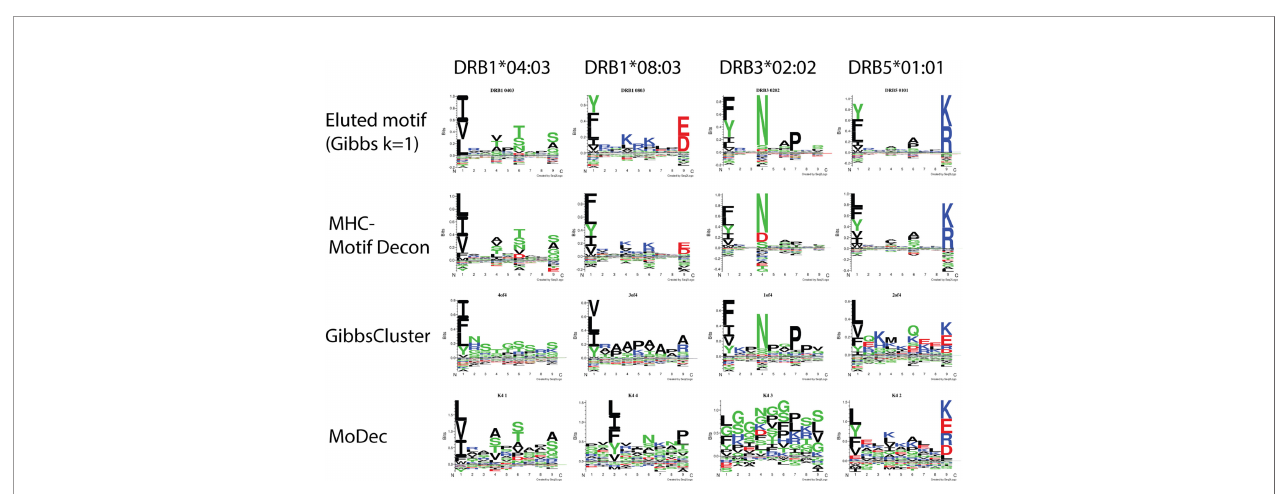
FIGURE 3 | Motif deconvolution of the arti fi cial dataset combining MS eluted ligand data from 4 cell lines each one expressing one individual HLA-DR allele. The three methods MHCMotifDecon, GibbsCluster (8), and Modec (10) were run as described in Materials and Methods . Eluted motif corresponds to GibbsCluster deconvolution of each of the single allele datasets using a single cluster